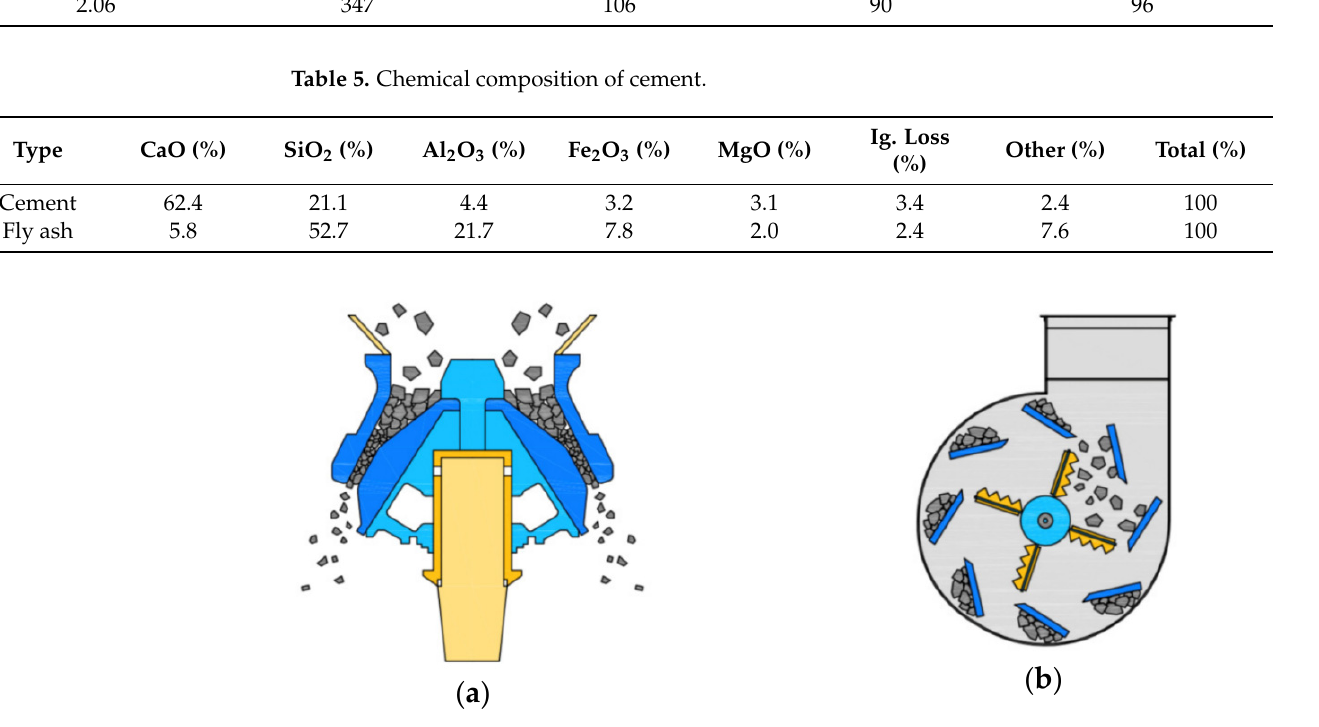
Figure 1. Manufacturing process of the recycled aggregate: ( a ) Type A; ( b ) Type B.